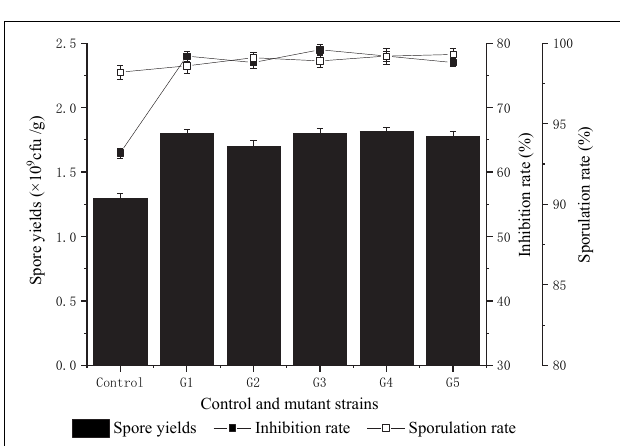
FIGURE 3 | The genetic stability of mutant T334. The comparative experiments were carried out for five consecutive generations with three samples. The results were the average of the three samples. All experiments were carried out as biological